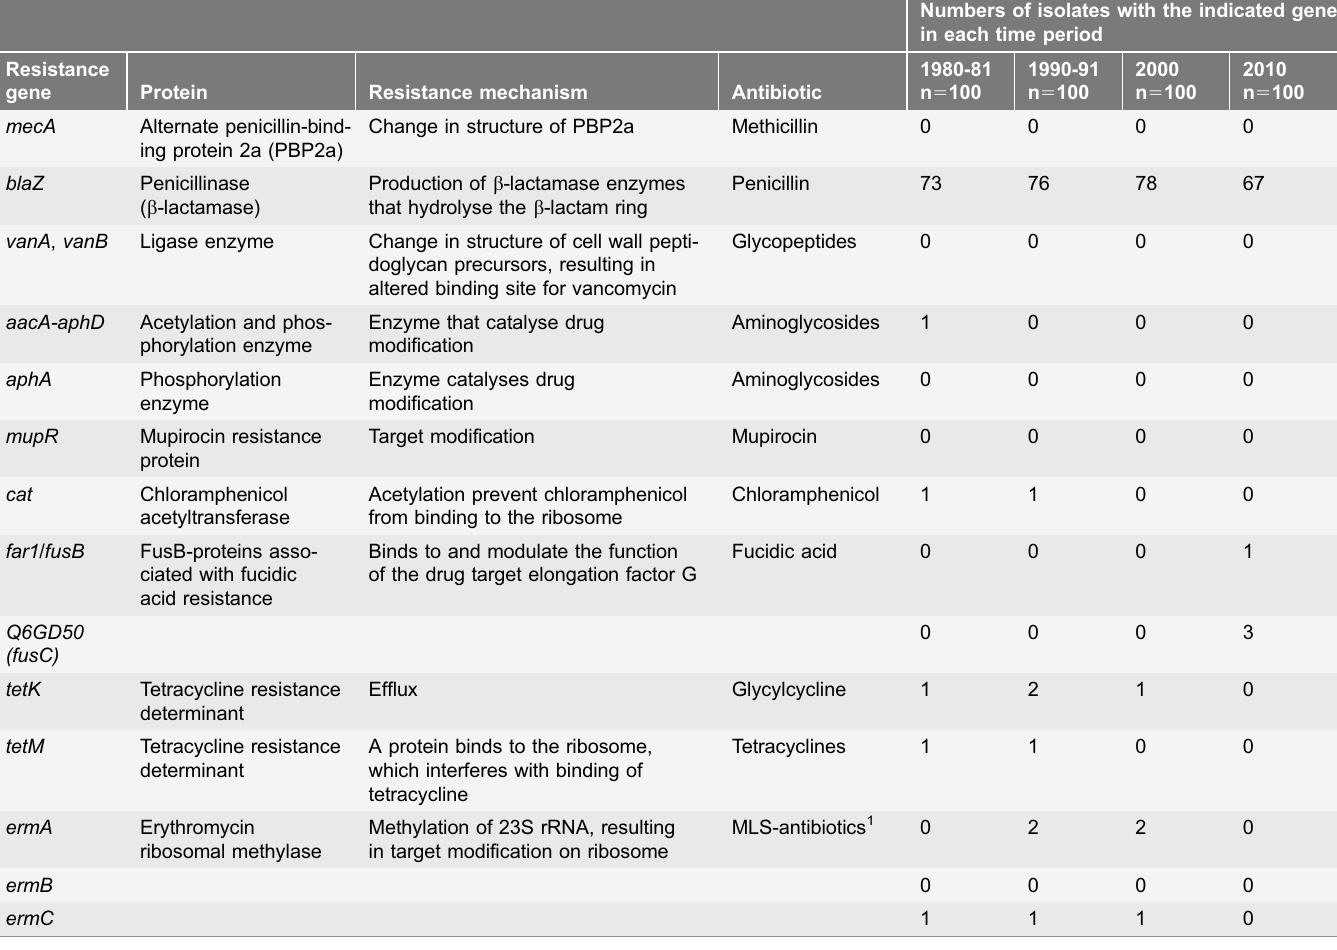
Table 2. Presence of antibiotic resistance genes in S. aureus isolated from blood cultures, the resistance mechanisms, and the corresponding antibiotics.